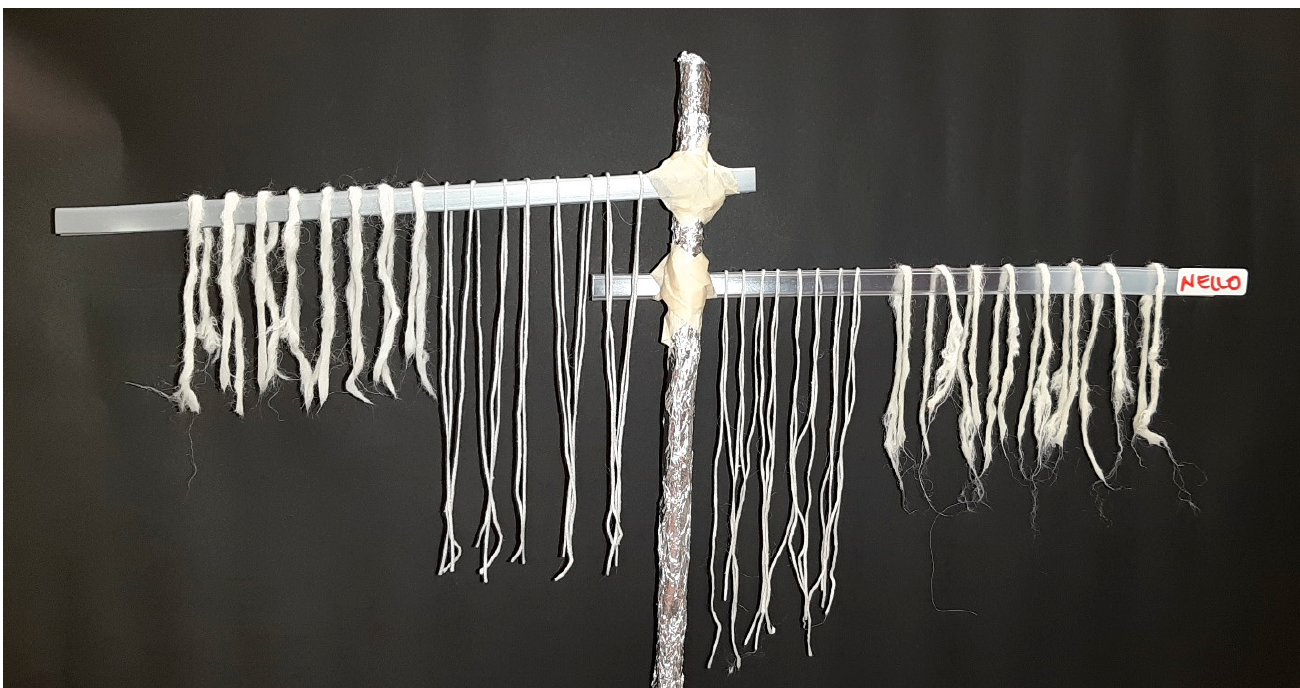
Figure 2. Image of the post-etching cotton and wool fibers: the treatment with aluminum potassium sulfate (left) and lemon juice (right).